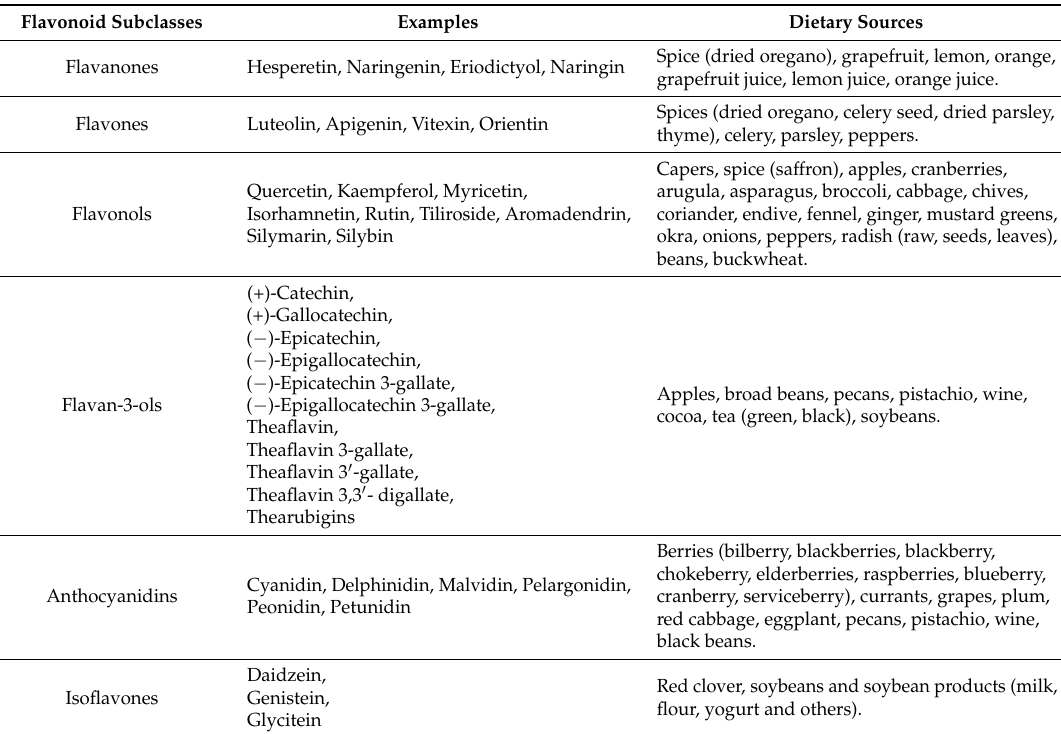
Table 1. Major subclasses of flavonoids with examples and some of the major dietary